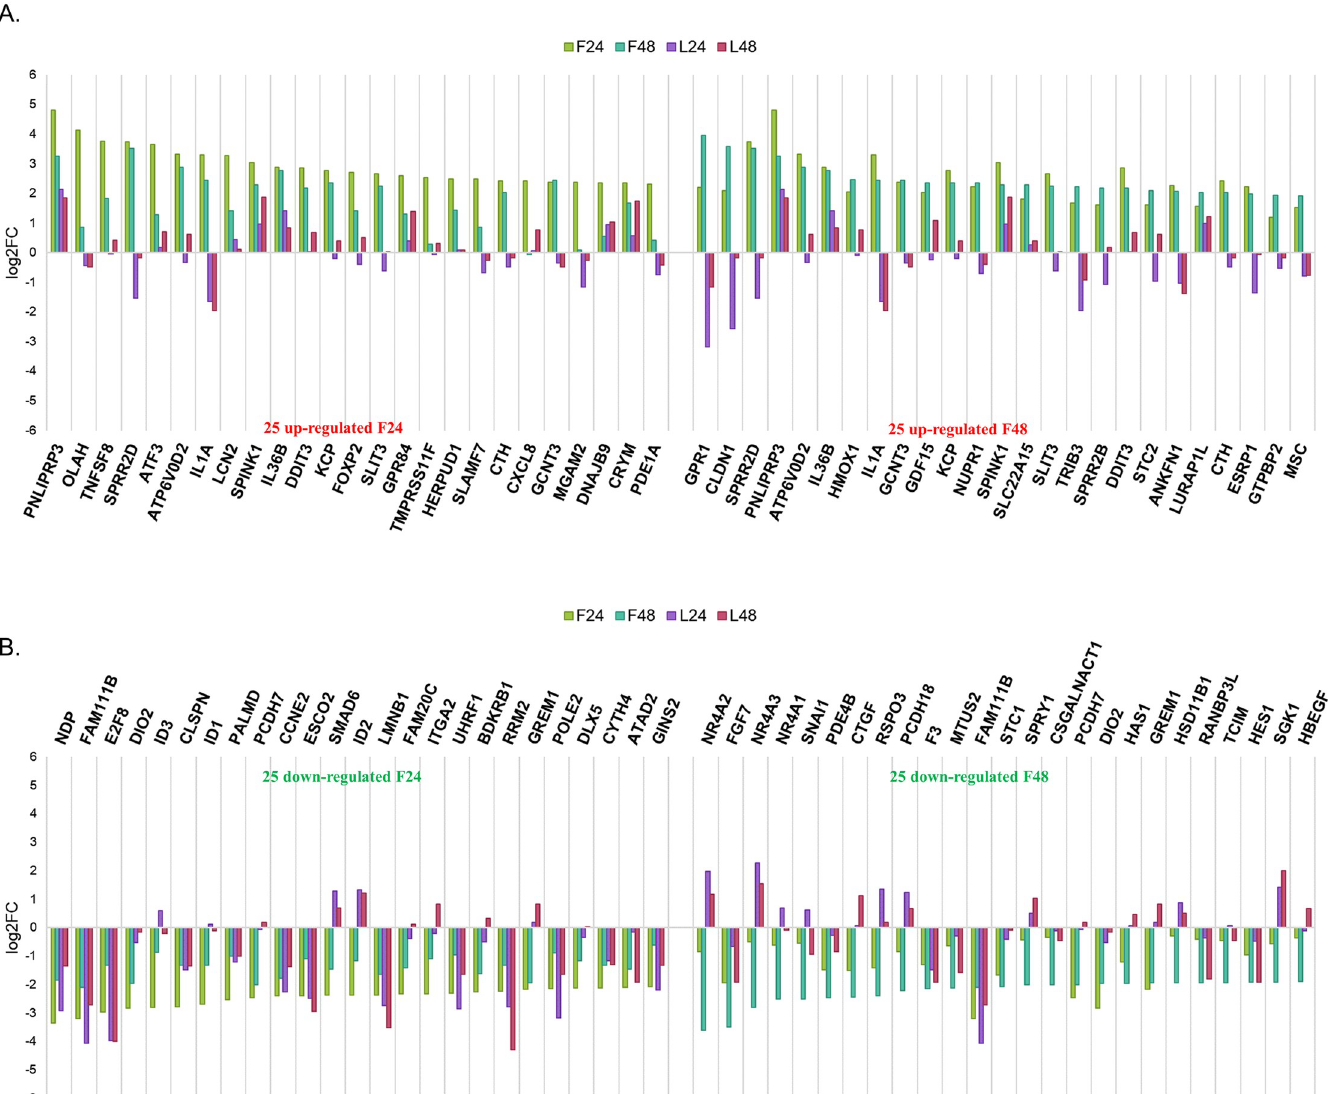
Fig 5. Gene expression differences between the 25 most differentially expressed up-regulated (A) and down-regulated (B) genes after fucoxanthin at 24h (left side) and 48h (right side) treatment. The expression of an individual gene (log2FC) across all four conditions is marked in specific colors per condition (F24—light green, represents the expression of a gene after fucoxanthin at 24h treatment; F48—dark green, represents the expression of a gene after fucoxanthin at 48h; L24—mauve represents the expression of a gene after LY-294002 at 24h; L48—pink, represents the expression of a gene after LY-294002 48h). The response to fucoxanthin is more variable at the two time points and differs from that of